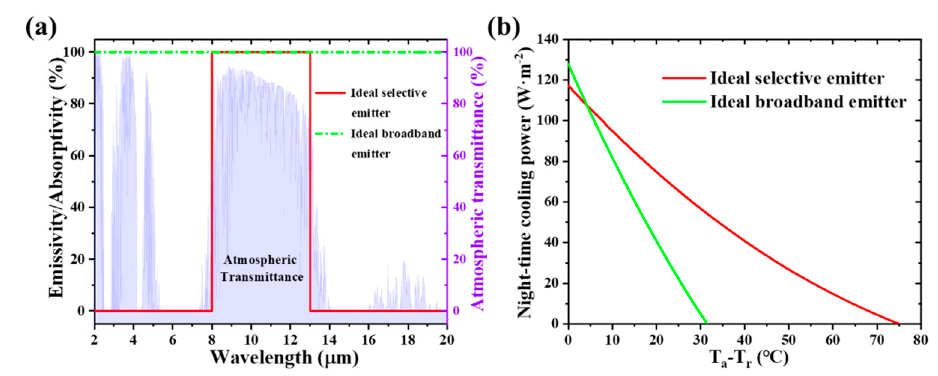
Figure 2. ( a ) IR emissivity / absorptivity of ideal broadband emitter and selective emitter; ( b ) Theoretical nighttime cooling performance of ideal broadband emitter and selective emitter with relative humidity 60%.